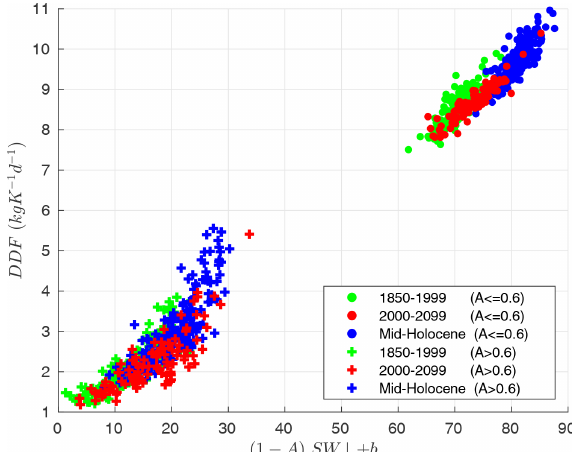
Figure 14. Degree day factors diagnosed from dEBM for the years 1850–1999 of the Industrial simulation (green), for the years 2000– 2099 of the Industrial simulation (red) and for the 200 years of ex- periment H6K (blue) as a function of the temperature-independent terms in Eq. (5). Each circle (cross) represents a domain-wide an- nual mean of all monthly values for which SurfaceType is WetSnow (SurfaceType is not WetSnow) weighted by melt